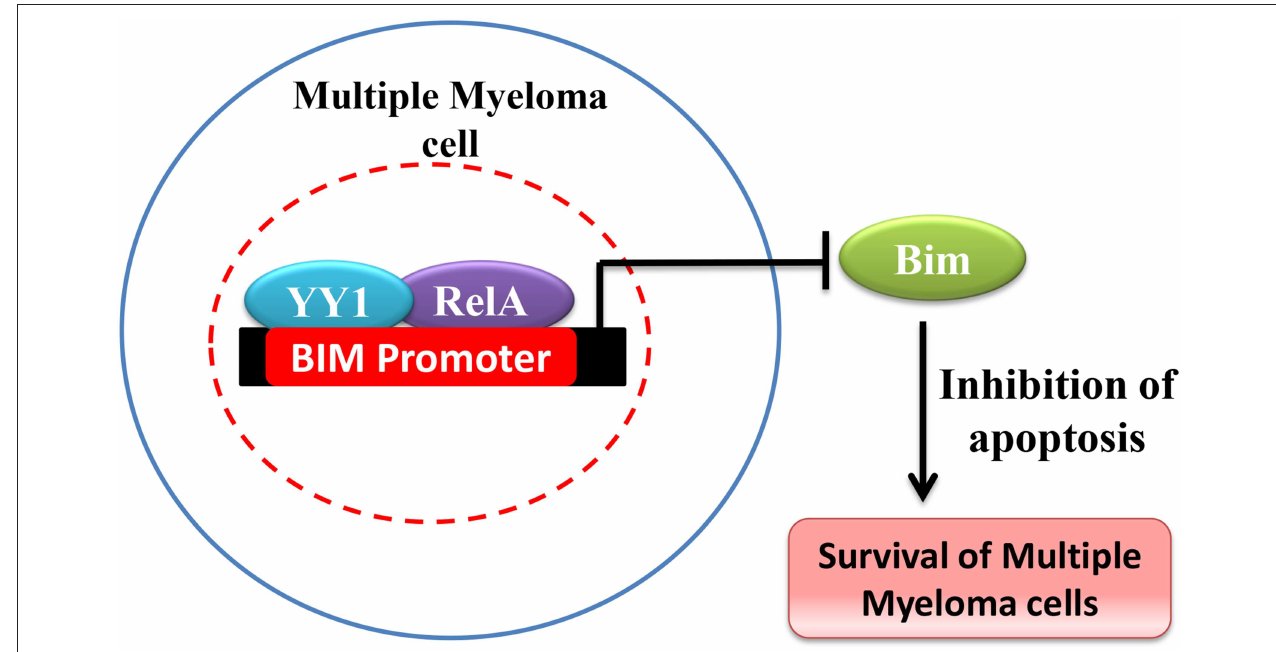
FIGURE 4 | Schematic representation of Bim repression by YY1-RelA complex. In Multiple Myeloma YY1 forms a complex with RelA and YY1-RelA complex represses Bim and promotes multiple myeloma cell survival and growth.